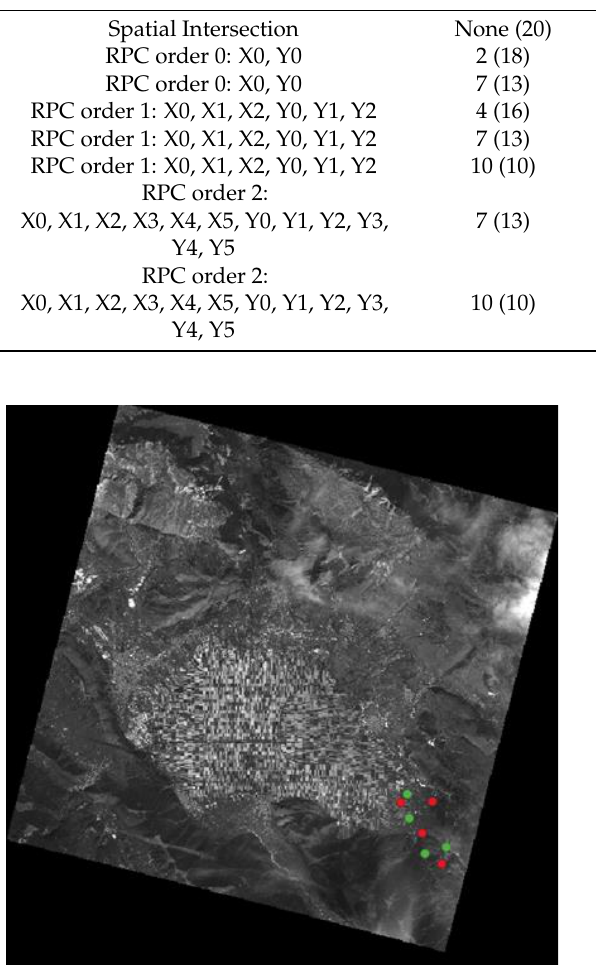
Figure 5. Ground point distribution for a small area of the image in the lower right corner, test field of Fucino (in red the GCPs, in green the CPs). Table 10. Results of RPC bundle adjustment with bias compensation for small area of the image in the lower right corner, test field of Fucino.